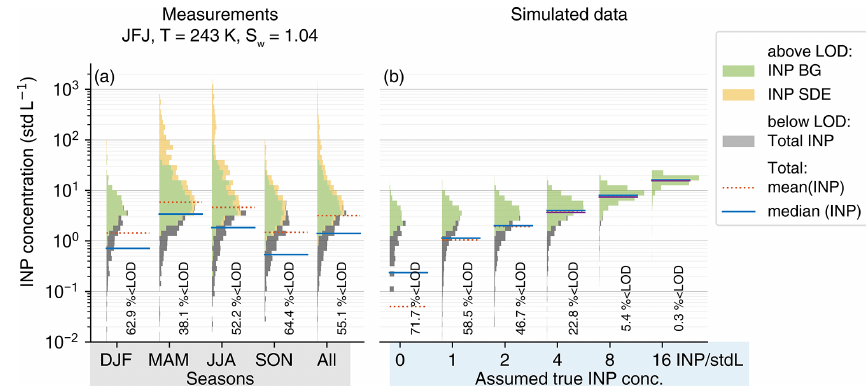
Figure 4. (a) Frequency distributions of INP concentrations measured in winter (December 2020, January 2021, February 2020), spring 2020–January 2021); (b) frequency distributions of simulated artificial INP concentrations with a prescribed INP concentration of 0, 1, 2, 4, 8, and 16stdL − 1 . Green indicates INP concentrations above the limit of detection (LOD) during BG conditions, yellow during SDE periods, gray INP concentrations below the LOD (independently of the air mass), red dashed lines the overall mean INP concentration, and the blue line the overall median INP concentration. Because of the log-scale, only positive concentrations are shown. The stated percentages indicate the fraction of measurements below the LOD. Table 1. Seasonal statistics of INP concentrations measured at JFJ at T = 243.15K and S w = 1.04 between 7 February, 7 February 2020, and 31 January 2021. INP concentration ± σ Q 25% (INP) Median (INP) Q 75% (INP) Q 95% (INP) P